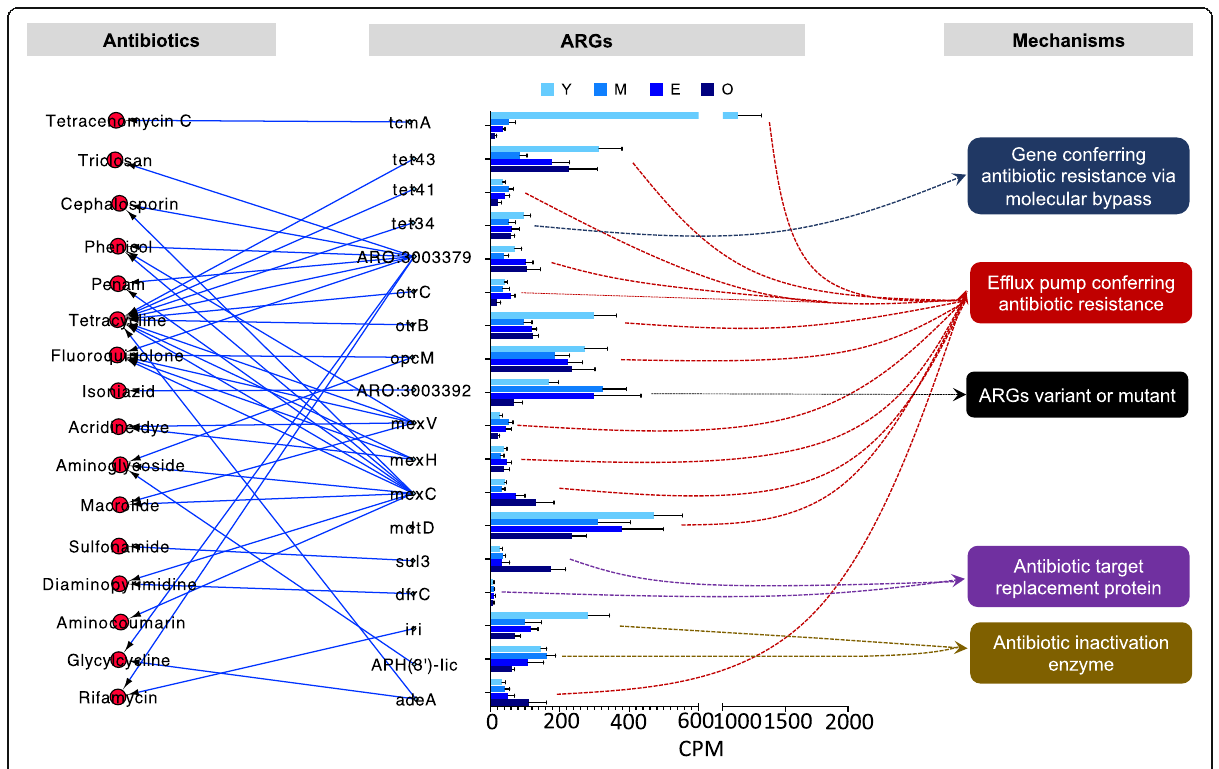
Fig. 4 The unique ruminal ARGs detected in the dairy buffaloes. The relative abundance, target antibiotics and resistant mechanisms of 18 unique ARGs identified in each sub-group (Y/M/E/O). ARGs: antibiotic resistance